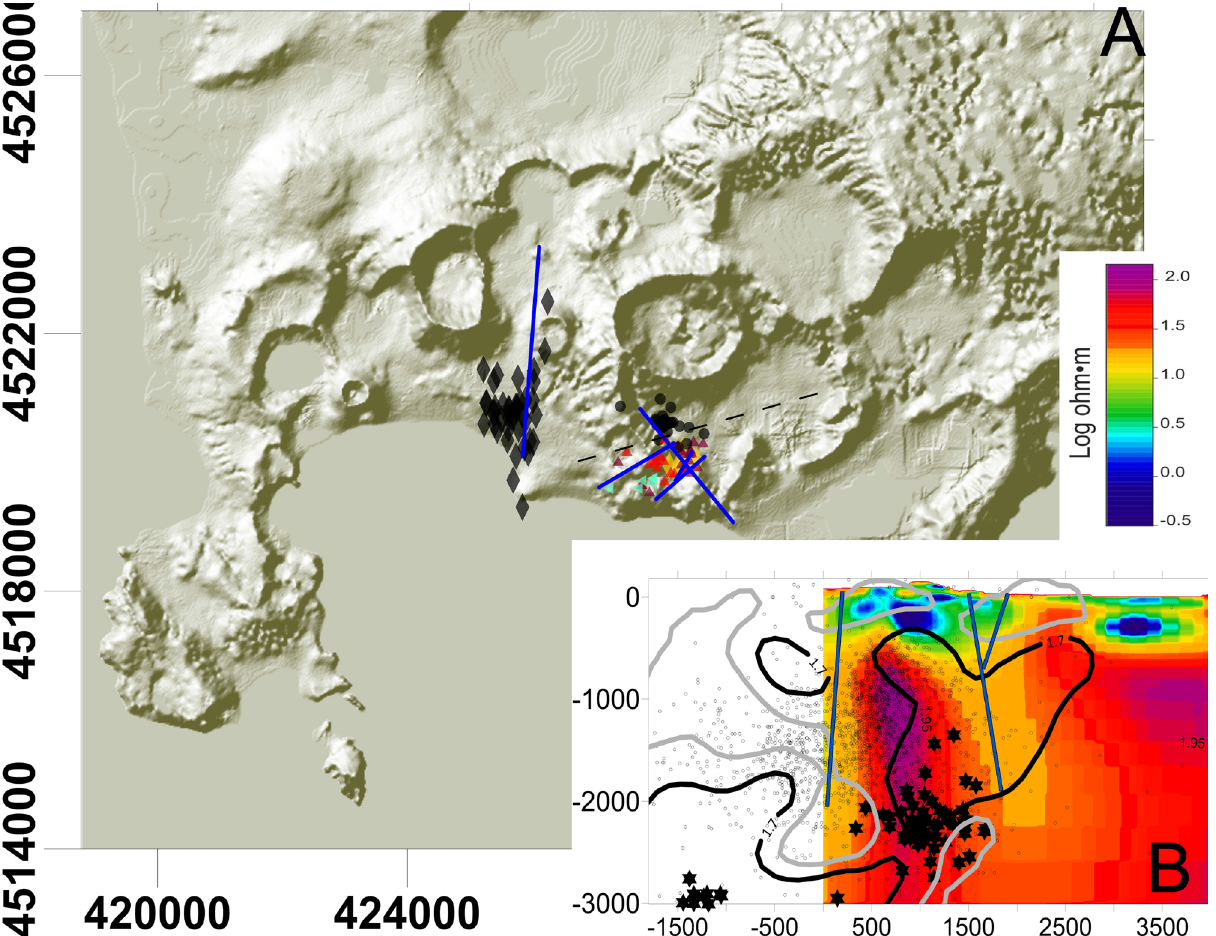
Figure 8. Slide A: Plot of the Campi Flegrei map with the indication of faults (blue lines) that overlap with the relocated swarms. The faults are taken by Vilardo et al. 29 . The swarms are: 2000-yellow diamonds; 2012-black diamonds; 2015—Bordeaux filled triangles; 2018—black filled circles; 2019—red filled triangles; 2020—left oriented light blue triangles. Black dashed line indicate the vertical projection of the resistivity tomography reported in slide B. Slide A was obtained using the software Surfer 22 (https:// www. golde nsoft ware. com/ produ cts/ surfer). Slide B: resistivity model modified after Siniscalchi et al. 30 adding the relocated events (black dots), swarms (black stars) and low (< 1.7) and high (> 1.9) Vp/Vs areas (black contours and grey contours, respectively). With blue line we reported the faults deduced by Siniscalchi et al. 30 thanks to the resistivity